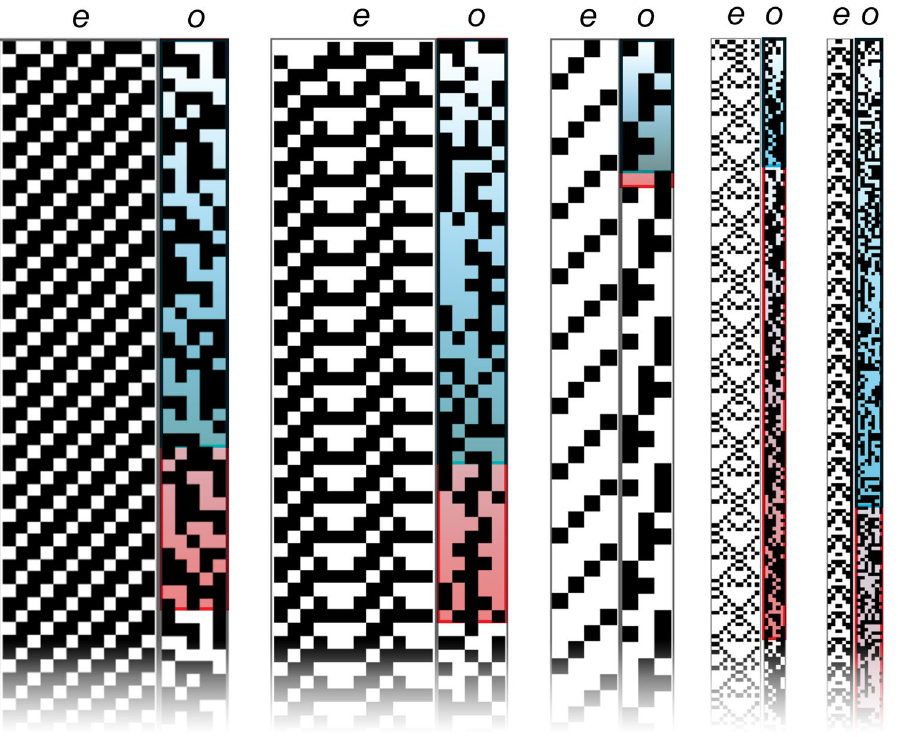
Figure 4. Examples of Case I CA exhibiting OEE. In each panel the environment e is shown on the left, and organism o on the right. For each o , the Poincaré recurrence time ( t P ) for an isolated system is highlighted in blue, and the recurrence time of the states of o , t r , is highlighted in